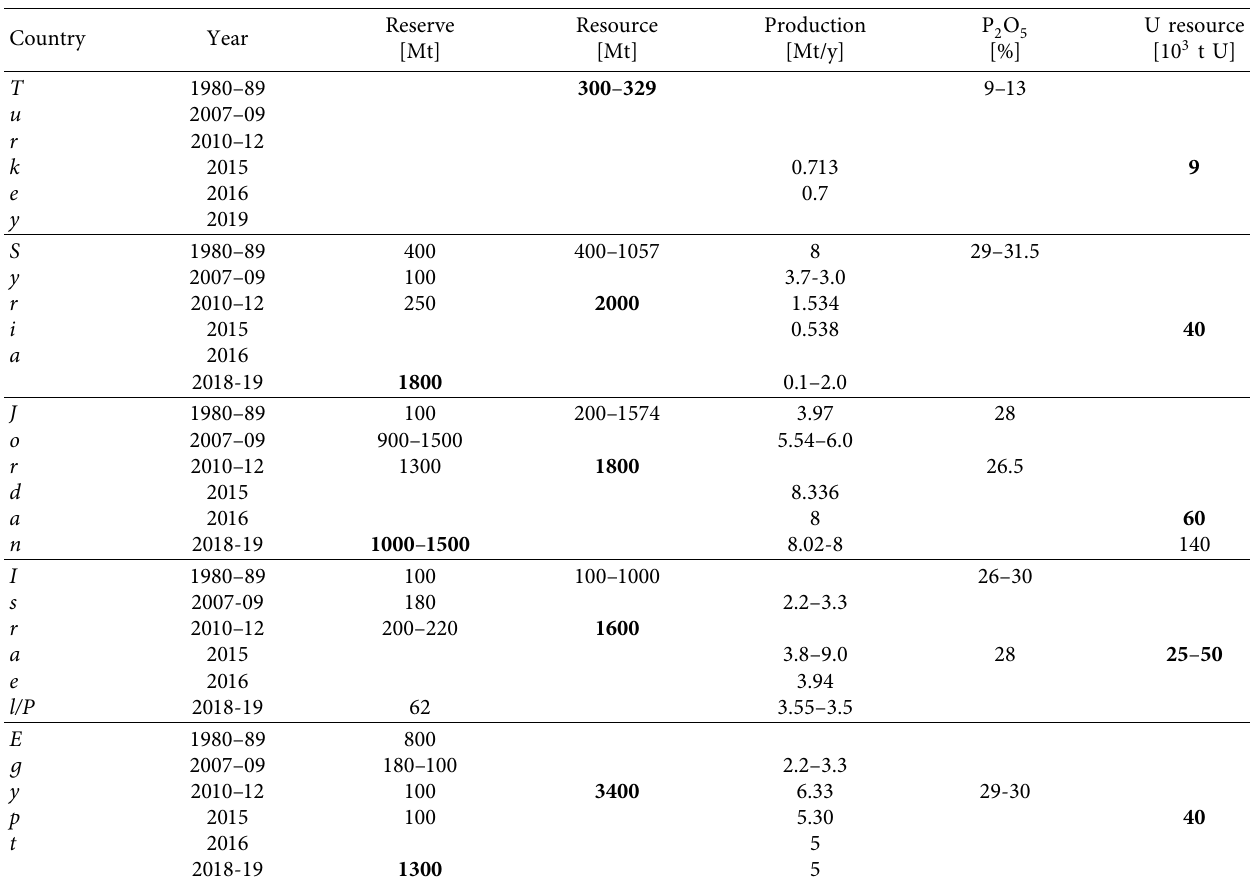
Table 5: Phosphate rock resources and annual productions, [20, 26], in countries of the EMC.